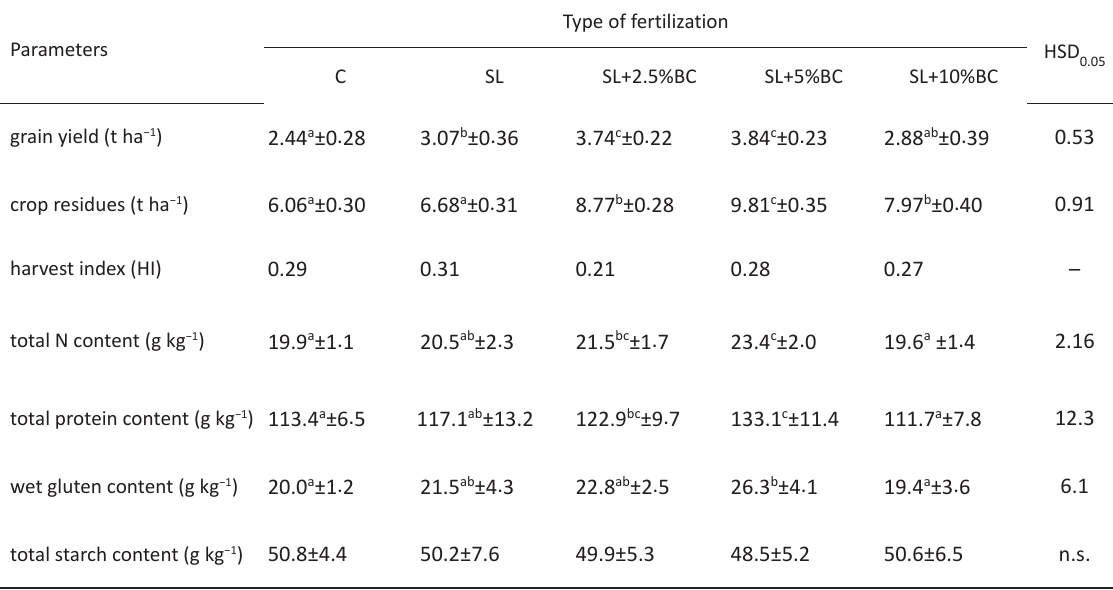
Table 2. The effect of sewage sludge (SL) and biochar (BC) application to soil on yield structure and protein, nitrogen, gluten and starch contents of spring wheat grain (mean, ±SD, n = 3)